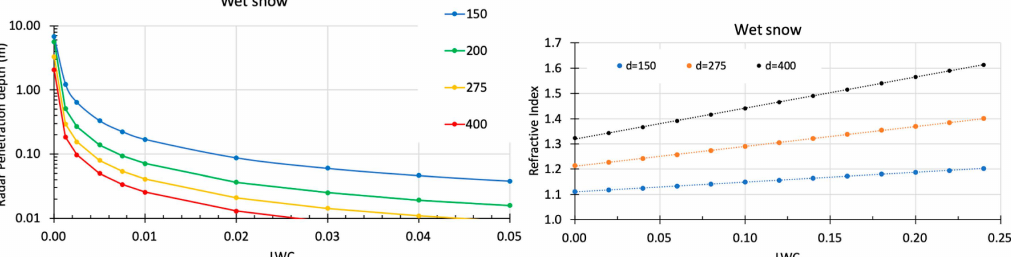
Figure A2. Radar penetration depth (m) (left) and refractive index (right) vs. density (kg m − 3 ) for dry snow.